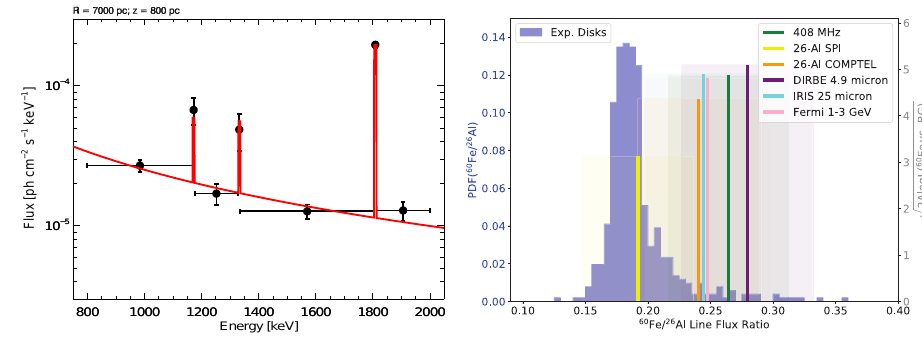
Fig. 7.— 60 Fe / 26 Al flux ratio for the grid of exponential disk models (blue, left axis). Including Figure 8. Left: The 60 Fe signal and 26 Al decay line intensities can be compared in INTEGRAL analyses the uncertainties of the fluxes from each spectral fit, the total estimated 60 Fe / 26 Al flux ratio from from a consistent set of observations [44]. Right: From modeling comparisons using a wide set of 4 . 2)% . Alternativeto exponential disks, we also show the flux ratios exponentialdisks is (18 . 4 ± di ff erent spatial distribution and tracer models, the gamma-ray intensity ratio 60 Fe / 26 Al is constraints derived from a set of tracer maps (see section 4.2), as vertical lines according to their significance (right axis), together with their uncertainties as shaded bands. Clearly, these systematically show to 0.4 as an upper bound . larger values compared to the exponential disk models. The IRIS (25 µ m ) map shows the largest improvementaboveabackgroundonlydescriptionforbothlinesconsistently(seeFig. 11),sothat a flux ratio estimate from this map serves as a measure of the systematic uncertainty. We find the 0 . 4 basedontheIRAS25 µ mmap,suggestingasystematicuncertaintyoftheorder ratioof 0 . 24 ± of 6% .